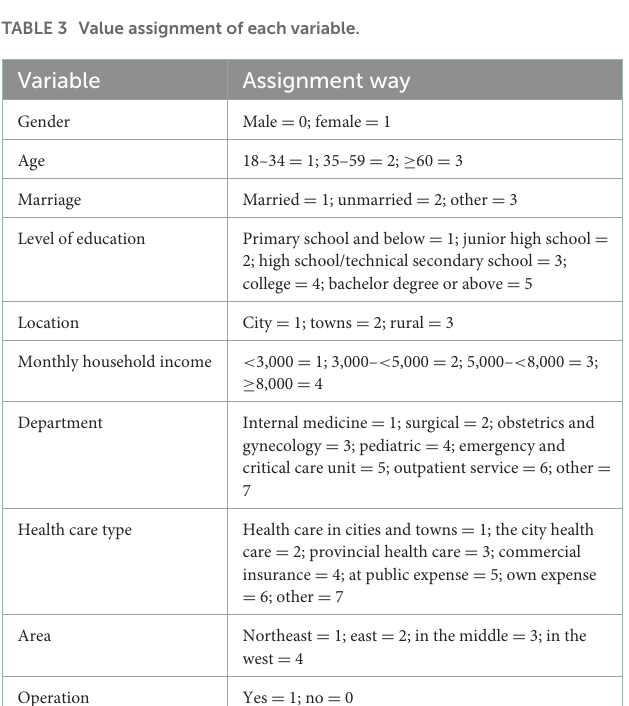
TABLE 3 Value assignment of each